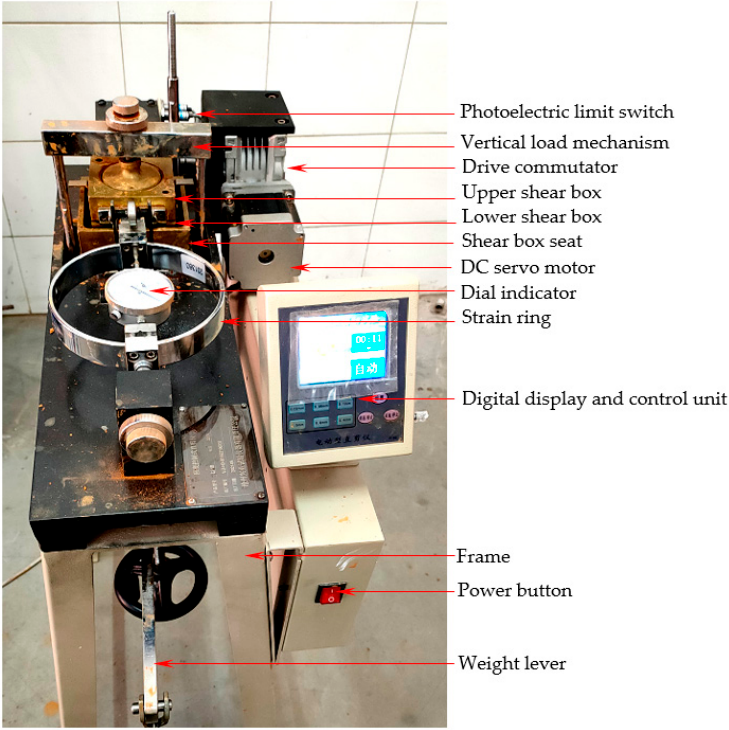
Figure 4. Strain-controlled direct shear test apparatus (ZJ-1B type).